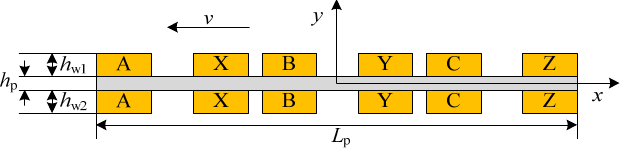
Figure 3. The analytical model of eddy current braking force.